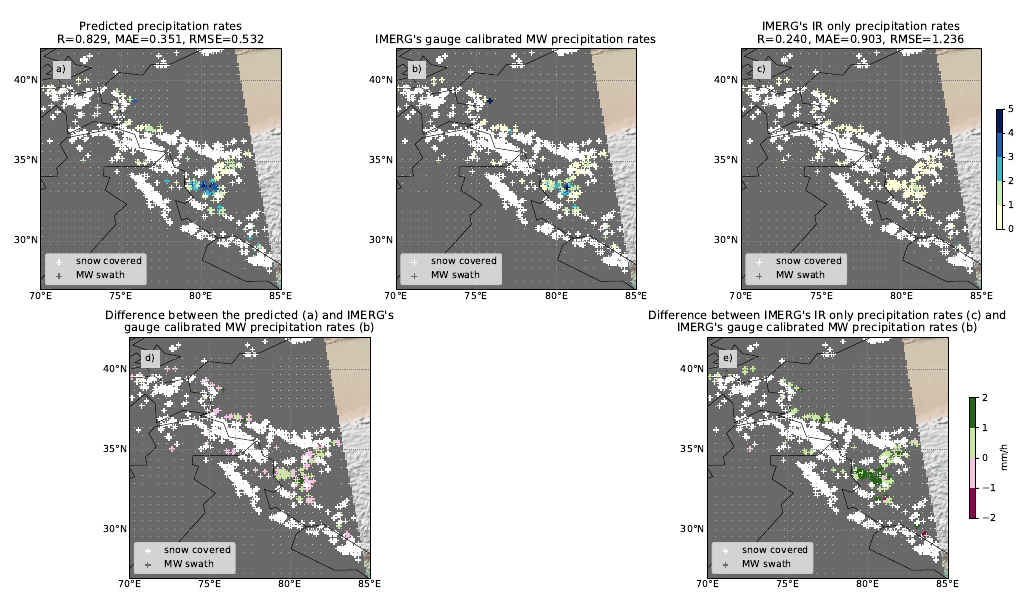
Figure 7. Comparison of ( a ) predicted precipitation rates with ( b ) gauge calibrated MW precipitation rates and ( c ) IR only precipitation rates at 2 August 2017 at 16:00 UTC. ( d ) shows the difference between ( a ) and ( b ). ( e ) displays the difference between ( c ) and ( b ). Green/pink represents the under-/overestimation of the predicted precipitation rates/IR only precipitation rates compared to the gauge calibrated MW precipitation rates. Grey represents the MW swath in which the gauge calibrated MW precipitation is available. White areas are pixels which were masked out due to snow/ice based on IMERG’s quality